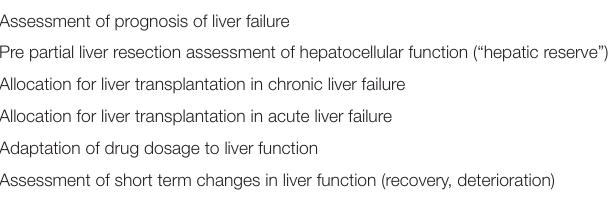
TABLE 9 | Indications for dynamic tests of liver function. Assessment of prognosis of liver